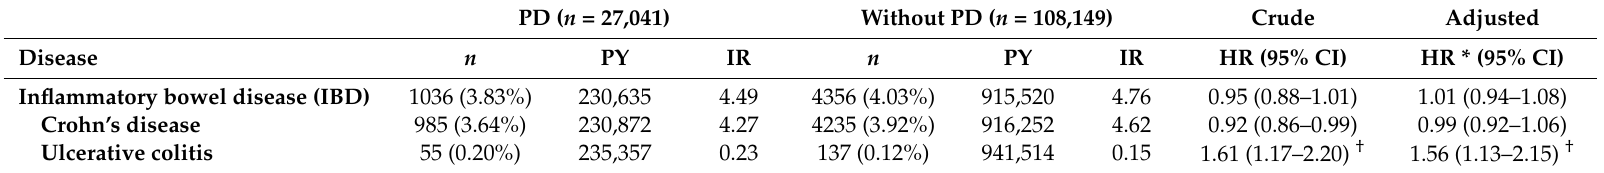
Table 2. The association between PD and IBD analyzed by Cox regression